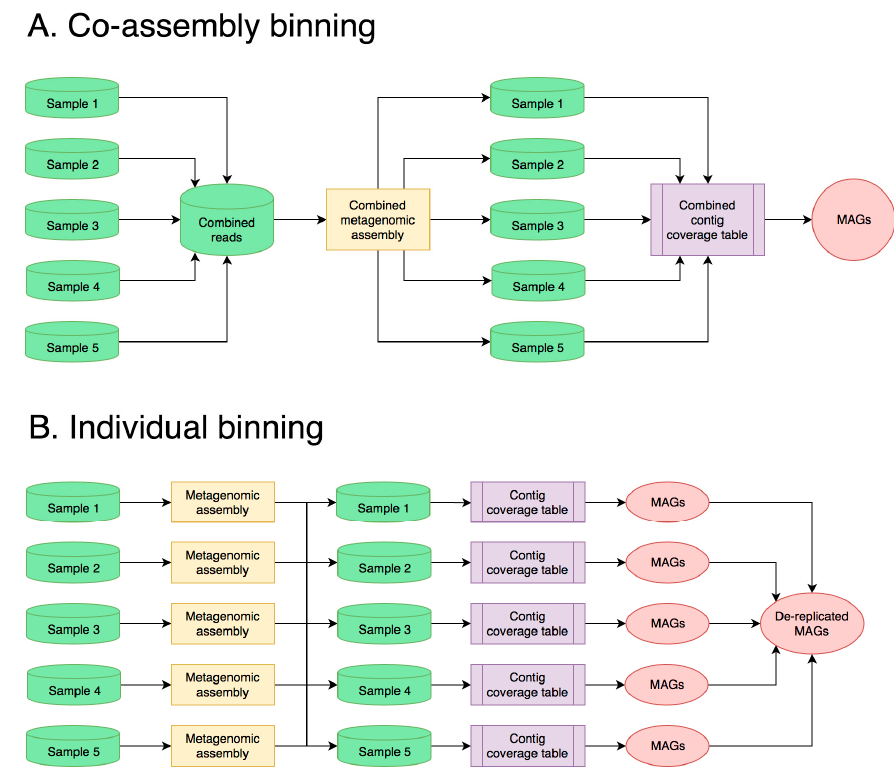
Figure 2. Flowcharts showing two common experimental designs and analysis workflows: ( A ) co-assembly and ( B ) individual sample processing and binning.